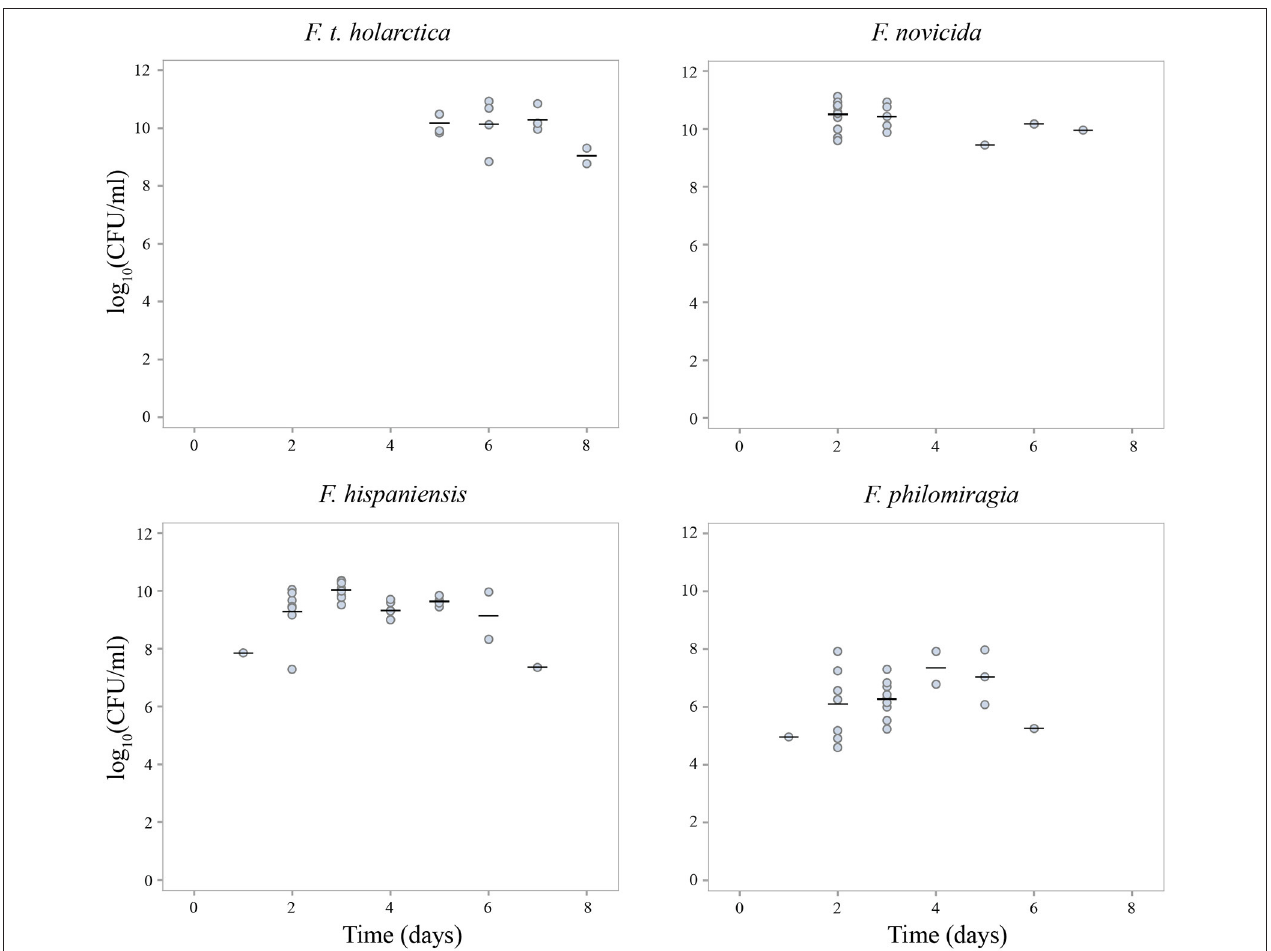
FIGURE 3 | Francisella spp. bacterial count in G. mellonella hemolymph upon larvae death ( F. t. holarctica, F. novicida, F. hispaniensis, F. philomiragia ). Mean values for each day are indicated by a horizontal line. Experiments were performed in three separate runs with 10 larvae in each run for each treatment. **Larvae producing a negative result in the viable count analysis ( F. t. holarctica n = 6, F. novicida n = 0, F. hispaniensis n = 1 and F. philomiragia n = 6) were excluded from the